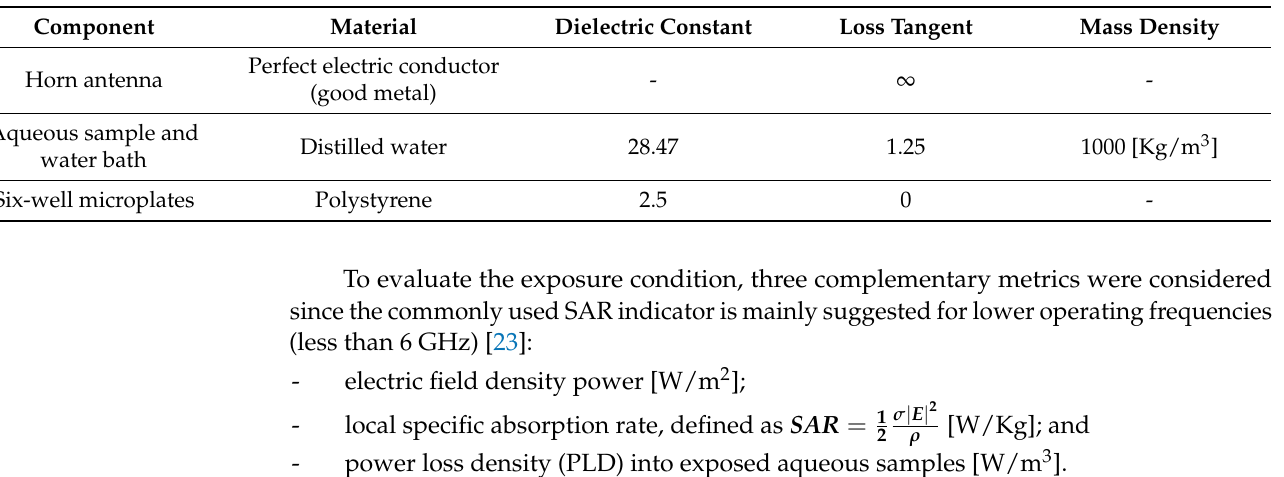
Table 1. Dielectric parameters adopted for the numerical